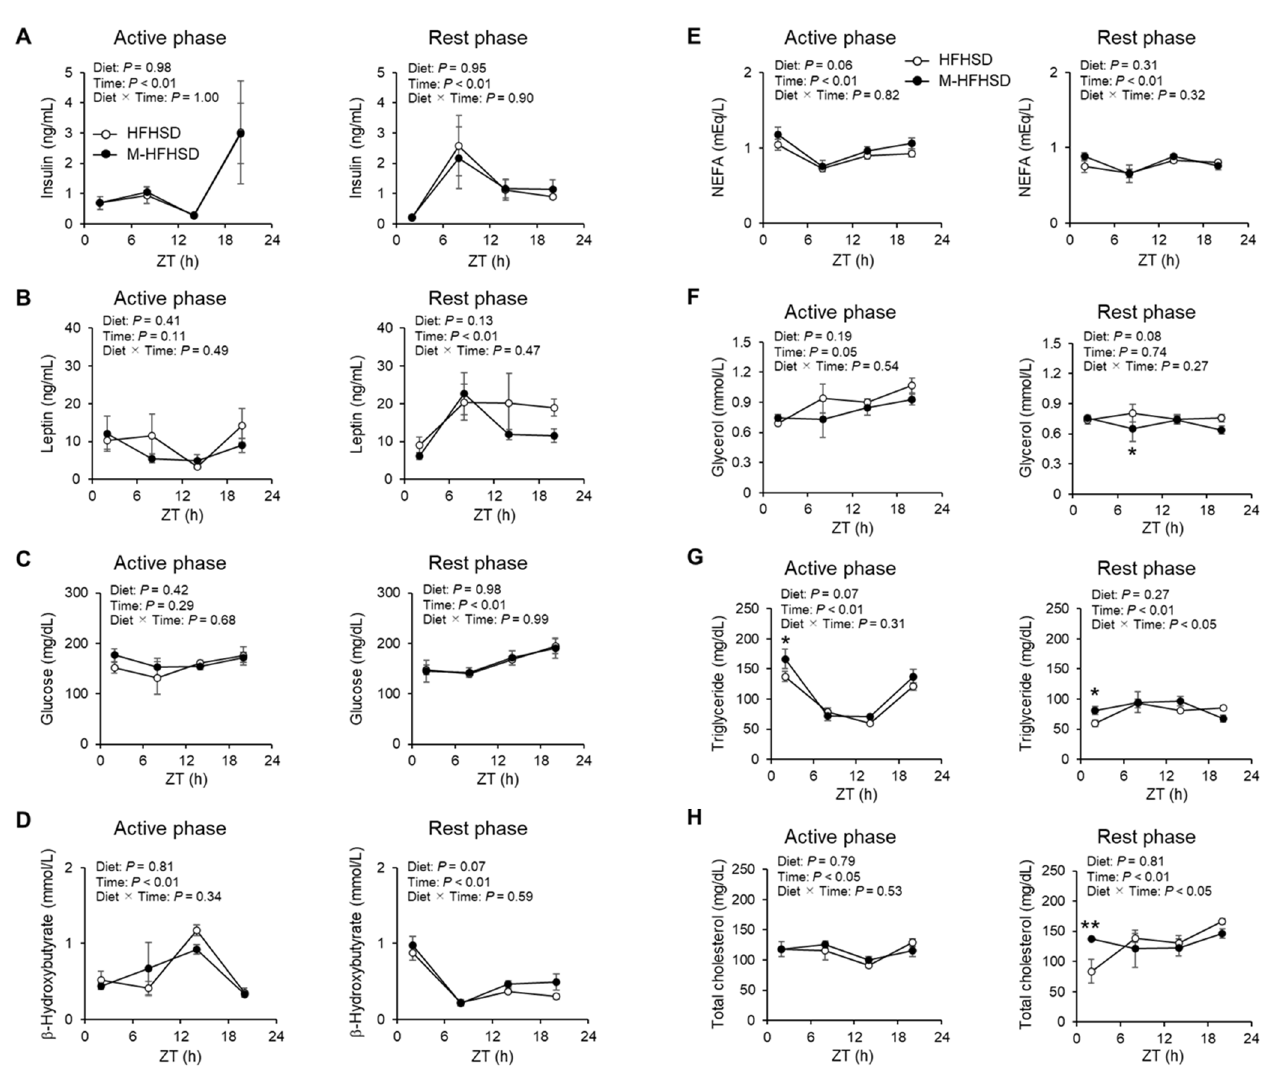
Figure 3. Serum hormone levels and metabolic parameters. Serum levels of insulin ( A ), leptin ( B ), glucose ( C ), β -hydroxybutyrate ( D ), NEFA ( E ), glycerol ( F ), triglyceride ( G ), and total cholesterol ( H ) at indicated times in mice fed with HFHSD or M-HFHSD for 9 weeks. Data are shown as mean ± SEM ( n = 4). * p < 0.05 and ** p < 0.01 vs. HFHSD at same time. HFHSD, high-fat high-sucrose diet; MCT, medium-chain triglyceride; M-HFHSD, high-fat high-sucrose diet containing medium-chain triglyceride; NEFA, non-esterified fatty acid; ZT, zeitgeber time.